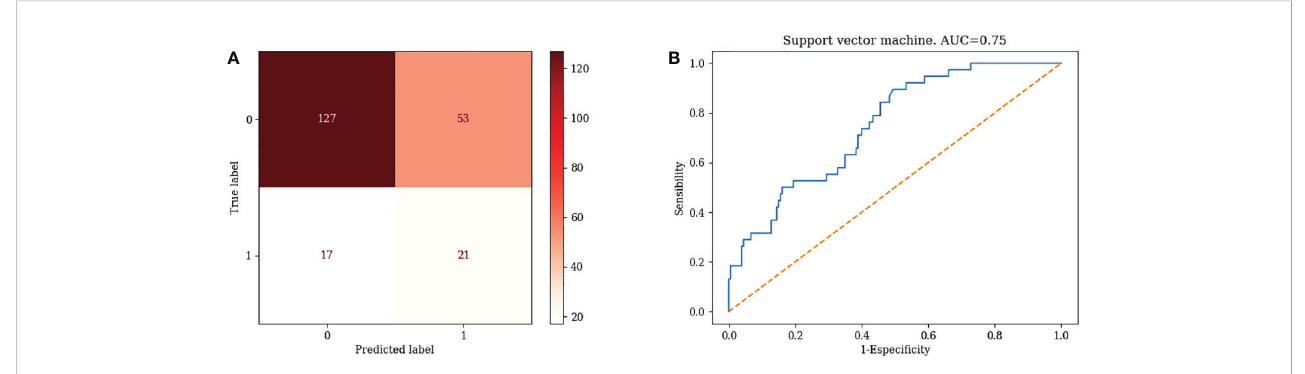
FIGURE 4 Confusion matrix and ROC curve of Support Vector Machine